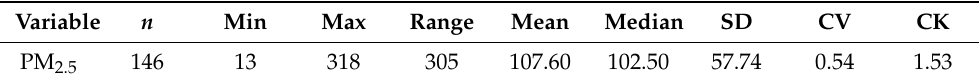
Table 1. Descriptive statistics for PM 2.5 recorded for the Pudahuel monitoring station during the CEM period in 2015 in Santiago, Chile.